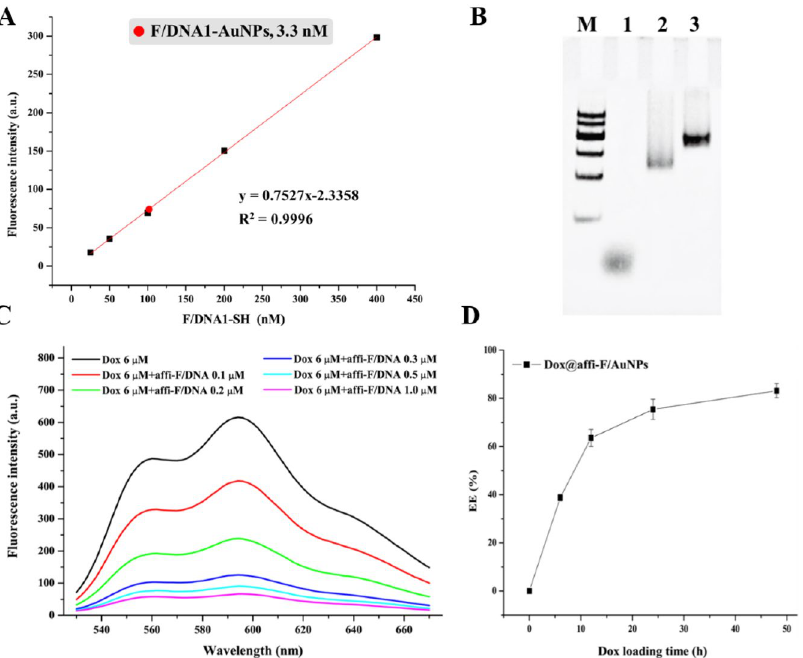
Figure 3. Drug loading analysis of Dox@affi-F/AuNPs. ( A ) DNA quantification of F/DNA1-AuNPs. ( B ) PAGE gel image which prove the duplex formation from affi-F/DNA. Lane 1, F/DNA1-SH; Lane 2, F/DNA2-affibody; Lane 3, affi-F/DNA hybrid strand. ( C ) The fluorescence spectra of Dox with various concentrations of affi-F/ DNA (0, 0.1, 0.2, 0.3, 0.5 and 1 μM). ( D ) The encapsulation efficiency (EE) of affi-F/AuNPs to Dox with different incubation time (0, 6, 12, 24 and 48 h).